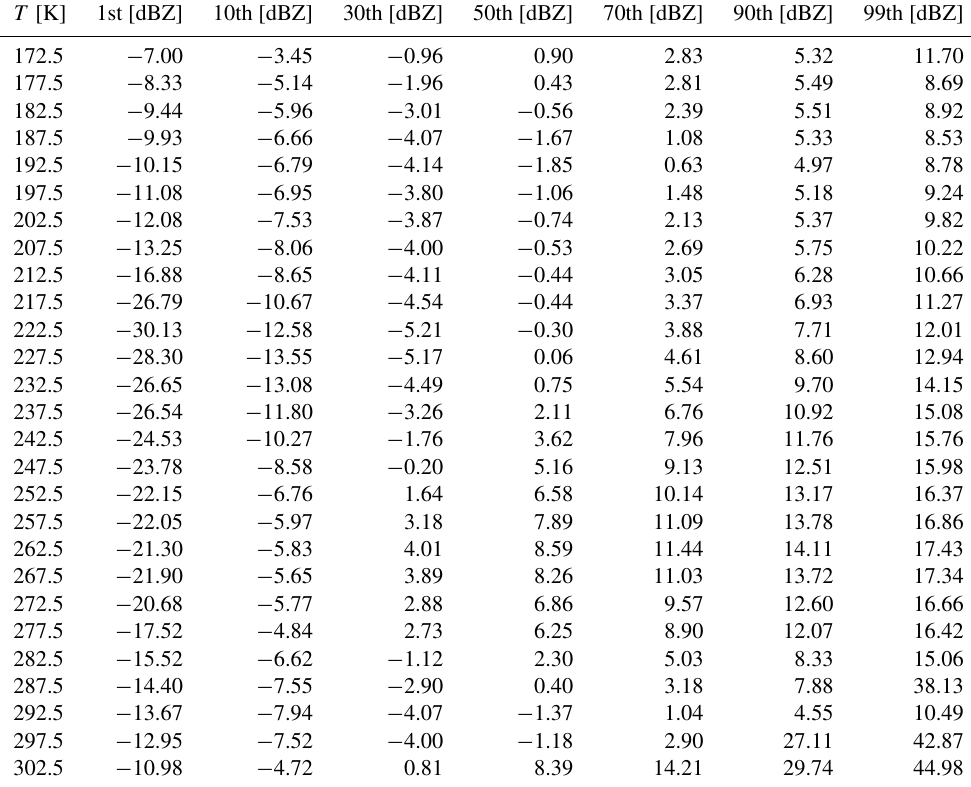
Table C1. Percentile of radar reflectivity factors ( Z ) in dBZ, shown as a solid line in Fig.